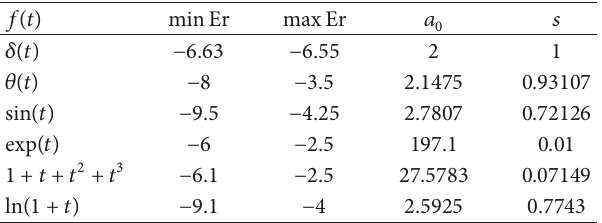
Table 1: Minimal and maximal logarithmic errors of approximation for various source functions: quadratic potential.